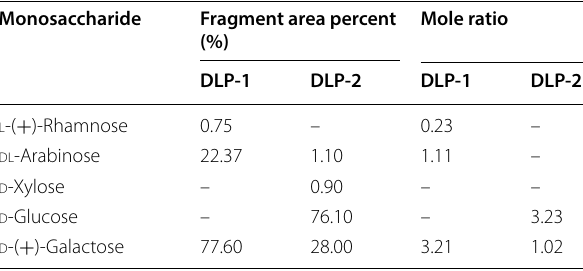
Table 2 GC–MS analysis of DLP-1 and